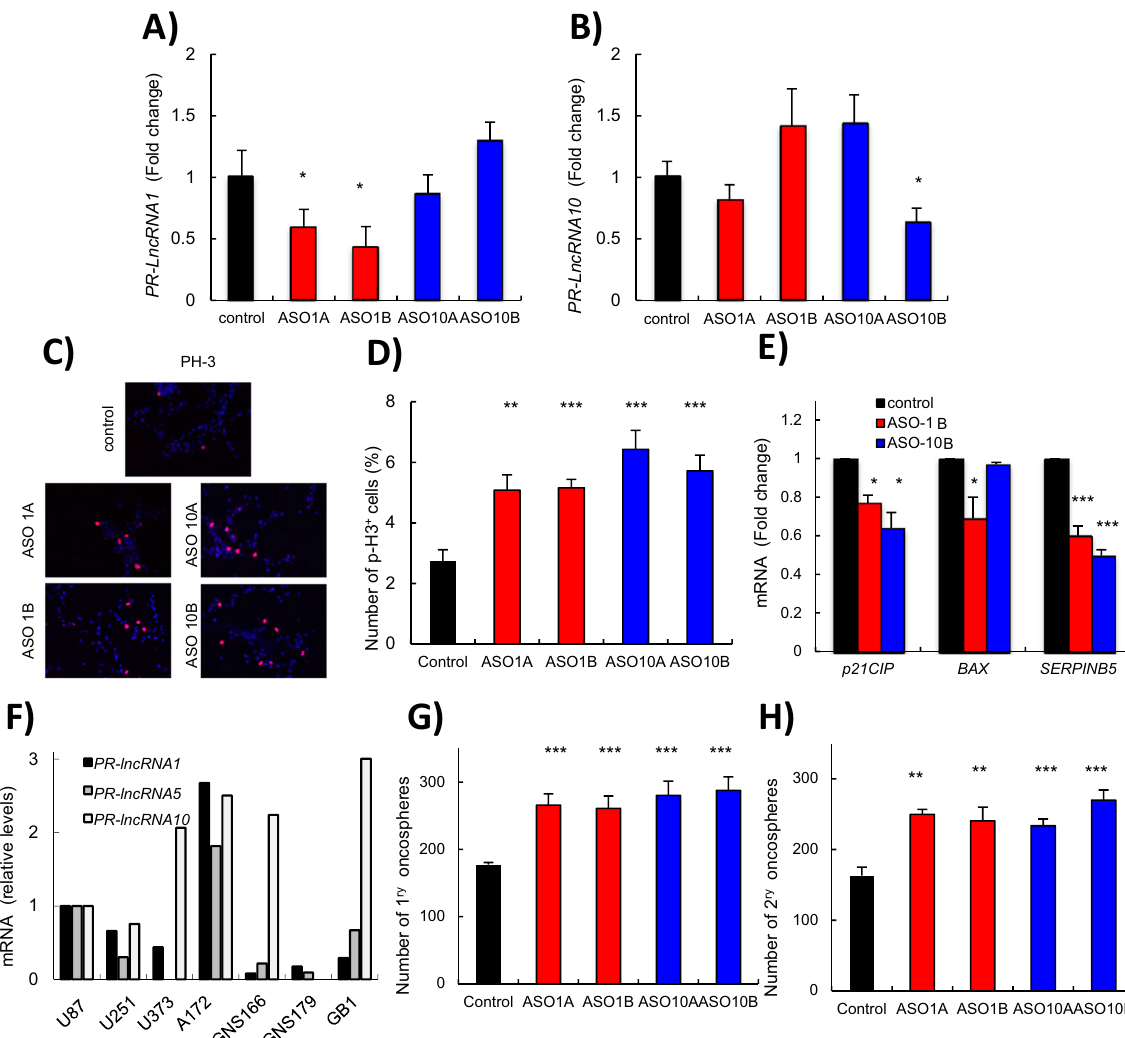
Figure 3. PR-LncRNA1 and 10 silencing leads to increased proliferation and stemness. U87-MG cells were transfected with specific ASOs for the PR-LncRNAs indicated. ( A,B ) Transfected cells were examined for PR-LncRNA1 and PR-LncRNA10 expression by quantitative reverse transcription polymerase chain reaction (n = 4). ( C ) Representative immunofluorescence of P-H3 in U87MG cells under the conditions indicated. ( D ) Quantification of the number of P-H3 positive cells under the conditions indicated (n = 4). ( E ) Quantification of mRNA levels of p21 cip , Bax and SerpinB5 in cells transfected with ASOs for PR-LncRNA1 and 10 and compared to cells with a control ASO ( F ) Expression of PR-LncRNA 1 , 5 and 10 in indicated conventional cell lines (U87-MG, U251, U373 and A172) and glioma stem cells (GNS166, GNS179 and GB1) ( G ) Quantification of primary oncospheres formed in ASO-transfected cells after 10 days in culture (n = 3). (H) Quantification of number of secondary oncospheres generated from disaggregating primary oncospheres in ASO-transfected and control cells. Numbers were assessed after 10 days in culture (n = 3). Asterisks ( * , ** and *** ) indicate statistical significance (p < 0.05, p < 0.01, and p < 0.001,